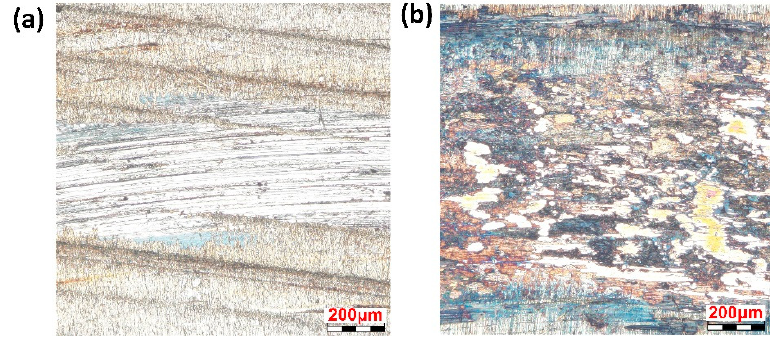
Figure 13. Optical morphologies of CuNiAl wear scars:( a ) in oil; and ( b ) in artificial seawater ( P = 106 N).